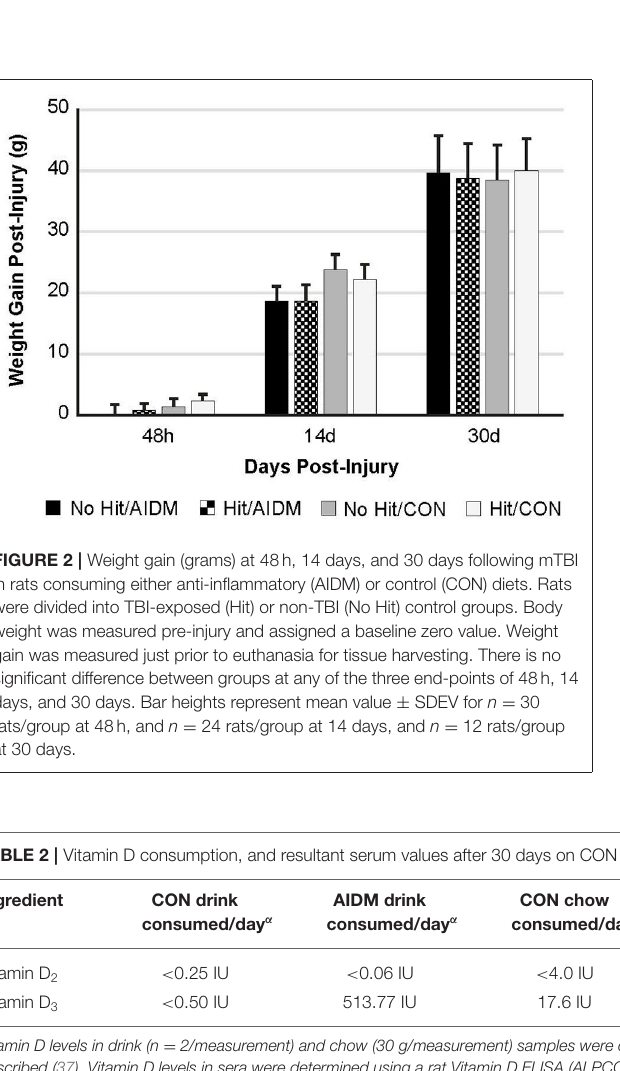
Vitamin D levels in drink (n = 2/measurement) and chow (30 g/measurement) samples were determined by liquid chromatography–mass spectrometry (LC-MS) methods as previously described (37). Vitamin D levels in sera were determined using a rat Vitamin D ELISA (ALPCO, Ltd.), which measures 25-hydroxyvitamin D 2 and D 3 . α Ratsconsumed 11.9ml( ± 0.6ml)CON/placebodrinkor12.4ml( ± 0.4ml)AIDM/Smartfishdrinkperday,5-days/week; # Ratsconsumed 23.3g( ± 1.3g)CON/placebochowor21.8g ( ± 1.5g) AIDM chow per day. * Statistically different values between CON and AIDM diet groups, P < 0.05. CON, control drink or chow; AIDM, anti-inflammatory dietary mix. Serum values are mean ± SDEV for n = 11–12 rats/group.